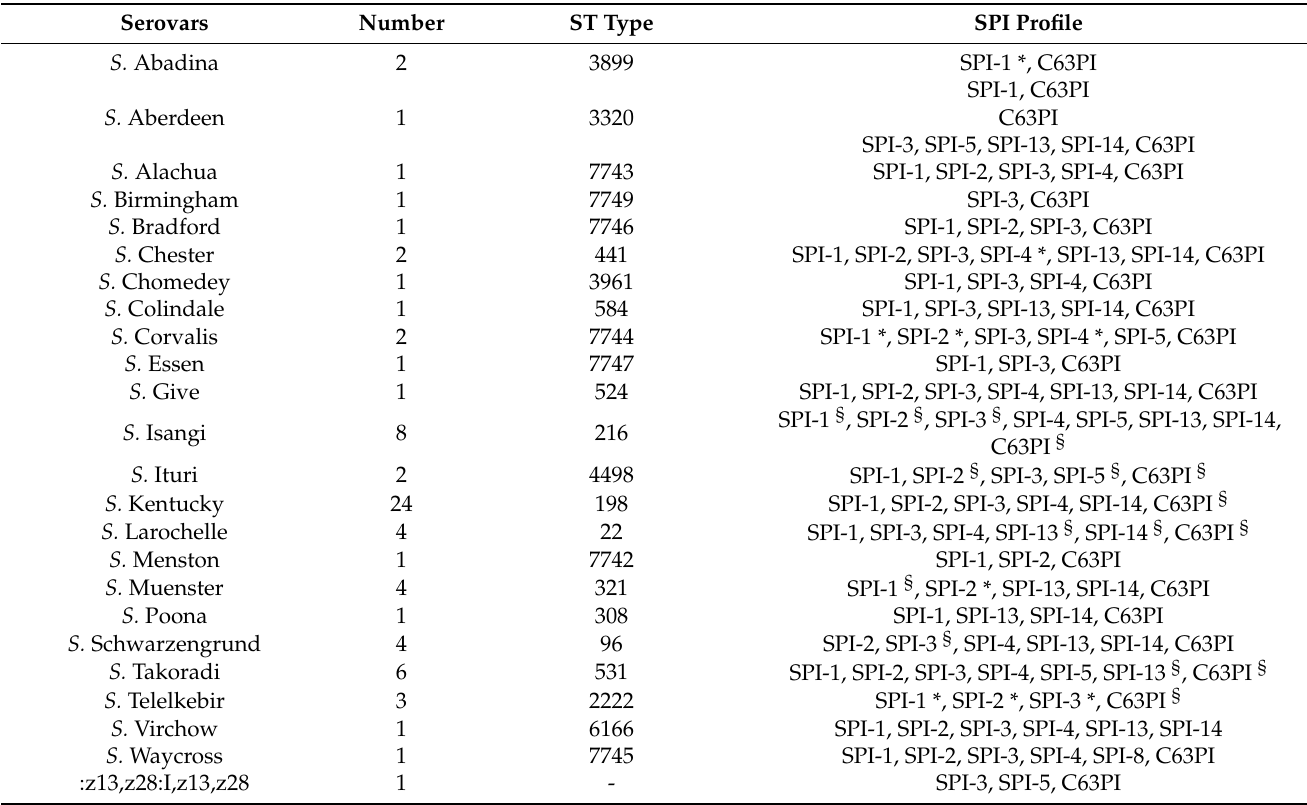
Table 4. Pathogenicity island content of Salmonella isolates from commercial poultry farms in